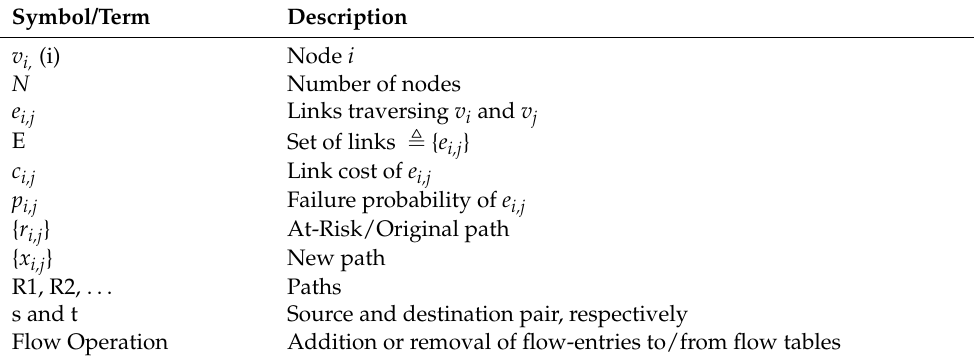
Table 1. List of Notations and Glossary of Frequently Used